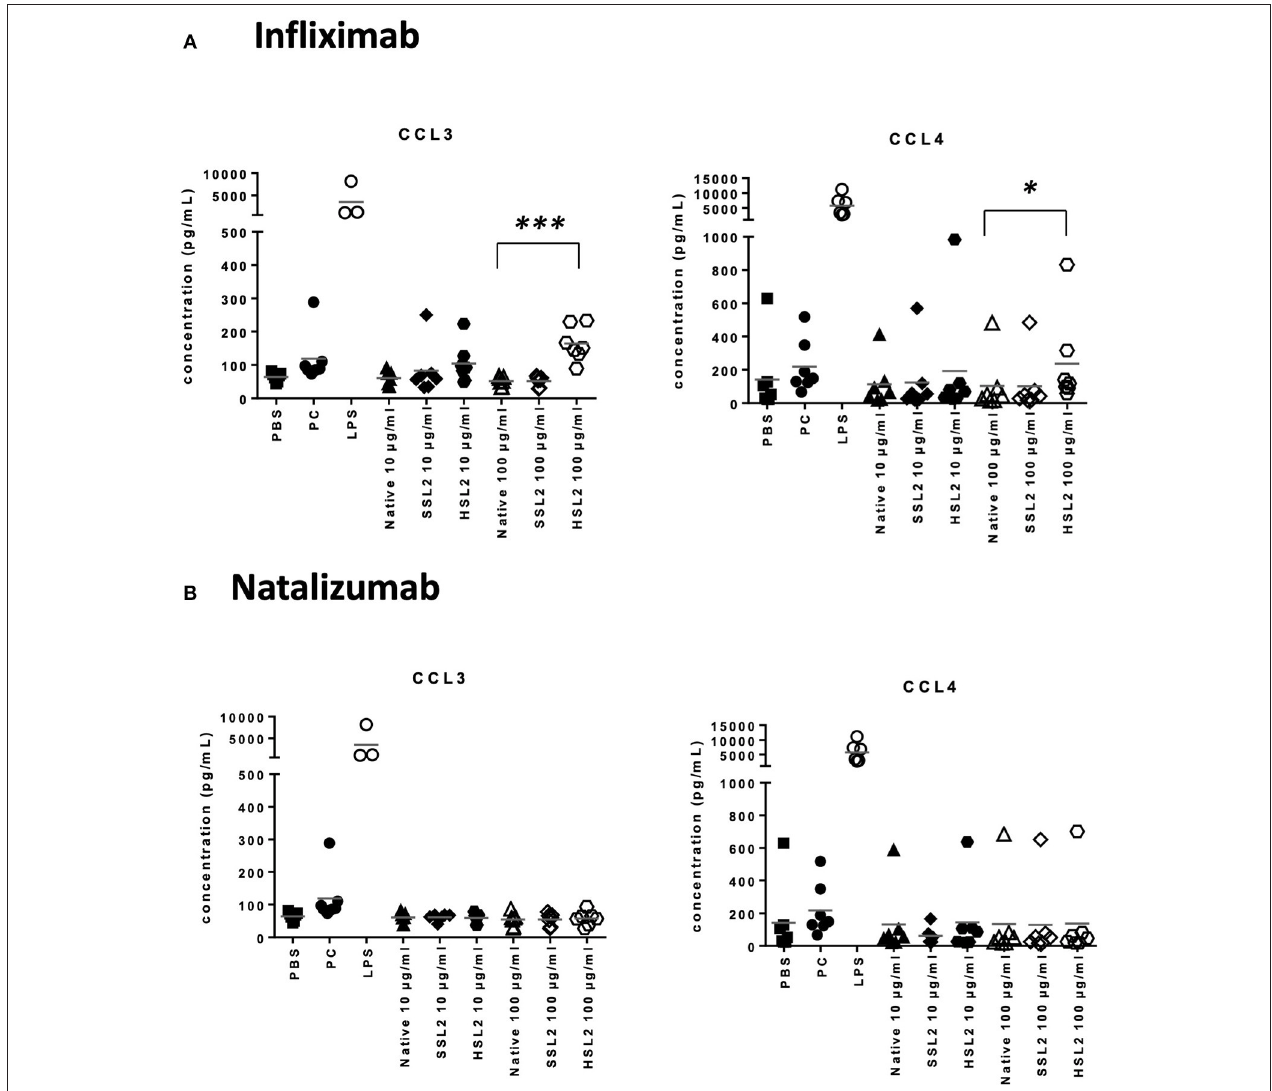
FIGURE 6 | Secretion of chemokines CCL3 and CCL4 secretions by moDC treated with native or aggregated infliximab (A) , and natalizumab (B) . Immature moDC were treated for 48h with native or stressed (SSL2 or HSL2) antibodies, maturation cocktail (MC) or LPS. Chemokine concentrations were measured in culture supernatants using a MSD multiplex assay. Results from seven independent experiments are shown. * p < 0.05; *** p <